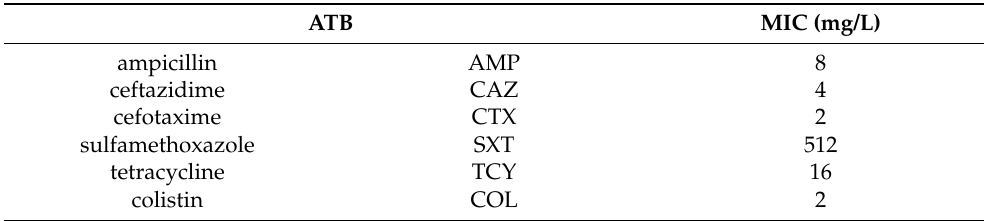
Table 1. Antibiotics and their concentrations used in cultivation